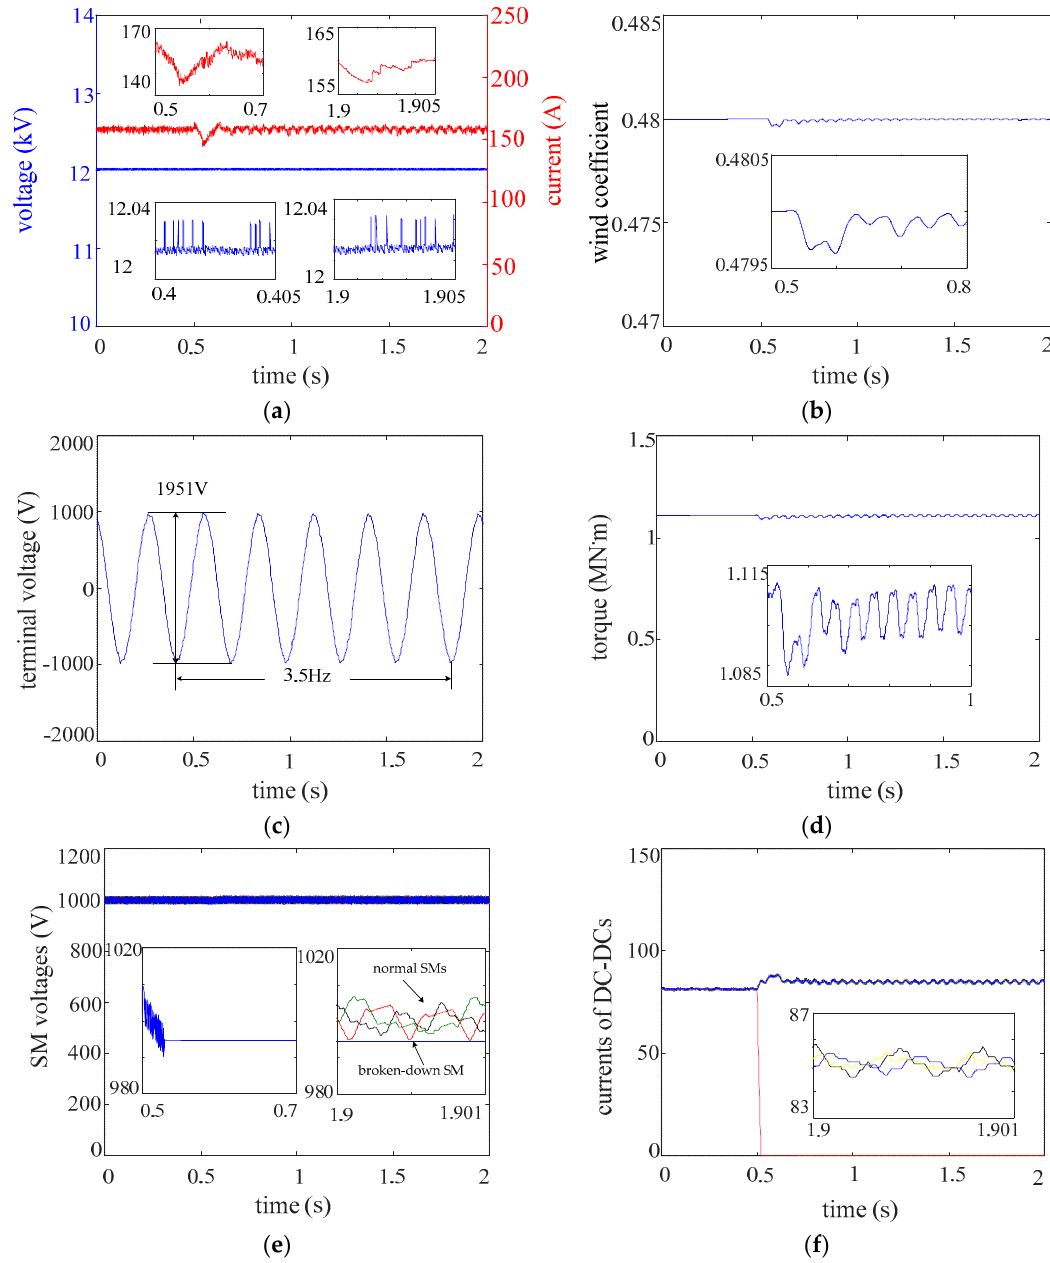
Figure 6. Simulation results when one DC–DC converter breaks down: ( a ) DC transmission voltage and current; ( b ) Wind power coefficient; ( c ) Terminal voltage of PMSG; ( d ) Electromagnetic torque; ( e ) SM capacitor voltages; ( f ) Currents of DC–DC converters.